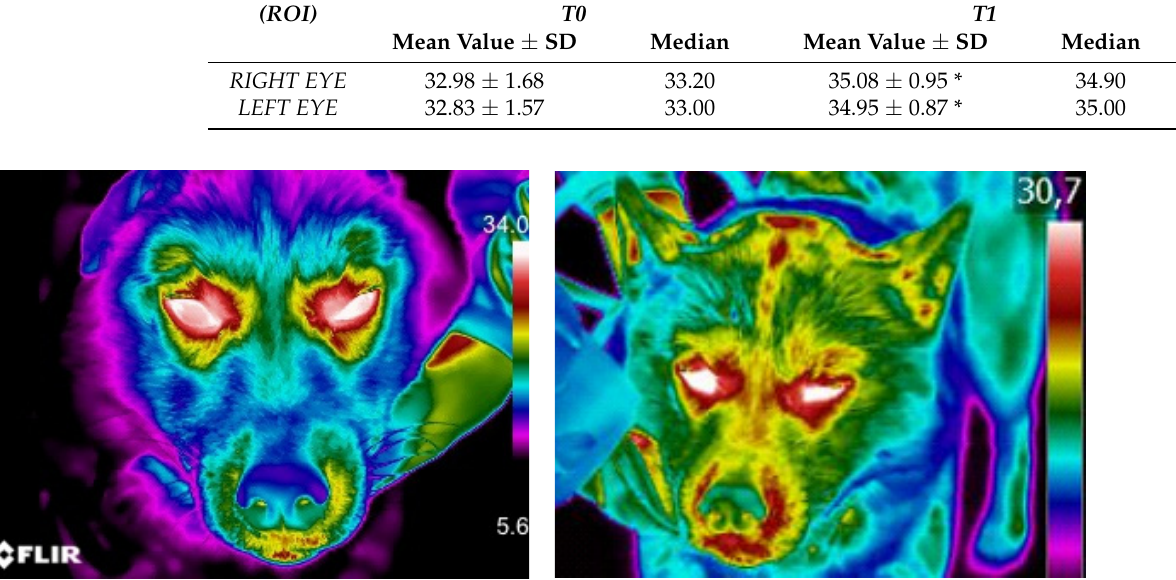
Figure 3. Five-year-old, female, Siberian Husky dog. Comparison of macroscopic thermographic aspect of ocular image before (T0) and after competition (T1). The brighter colors (red, orange, and yellow) indicate warmer temperatures (more heat and infrared radiation emitted), while the purples and dark blue/black indicate cooler temperatures (less heat and infrared radiation emitted).